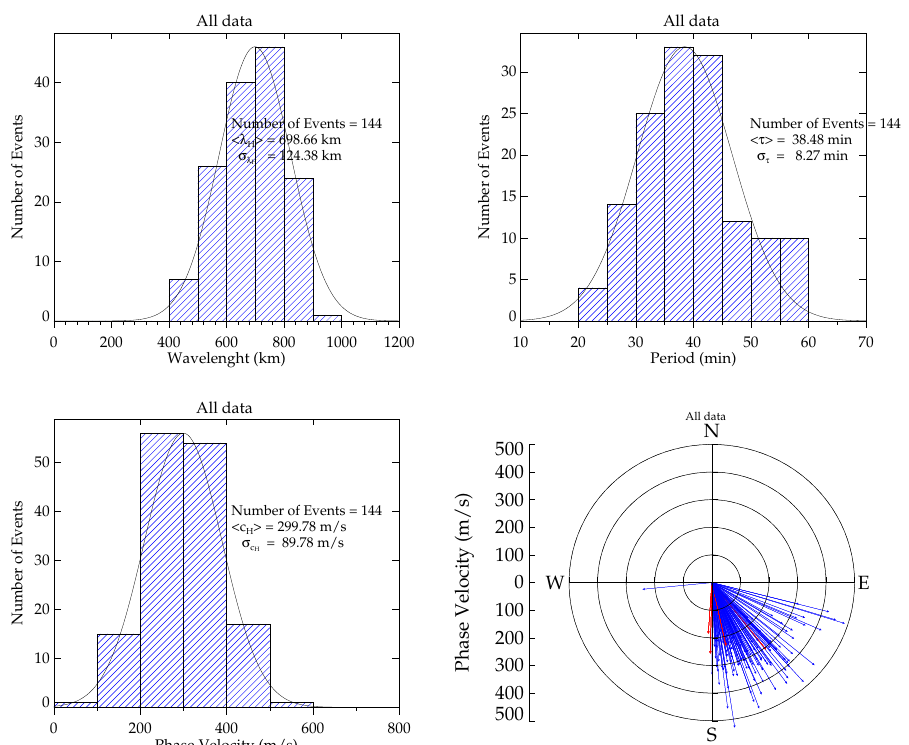
Figure 6. The wavelength, period, phase velocity, and propagation direction (red and blue arrows indicate the nighttime and daytime MSTID events, respectively) of the observed medium-scale traveling ionospheric